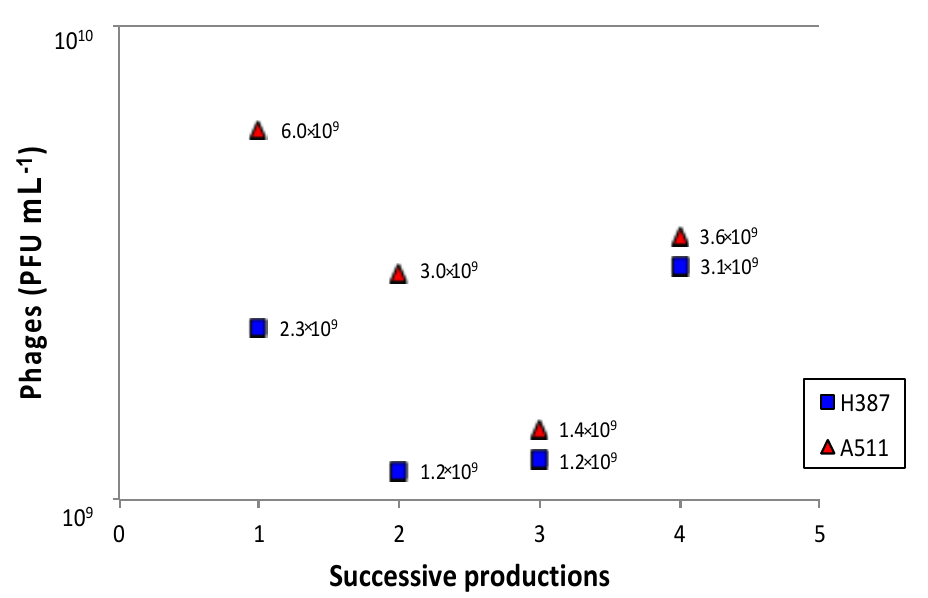
Figure 5. Successive productions of the two phages, A511 and H387, on Listeria ivanovii WSLC 3009 using a multiplicity of infection (MOI) of 1. Aliquots were withdrawn after 10 h of incubation. Mean values were calculated from two independent